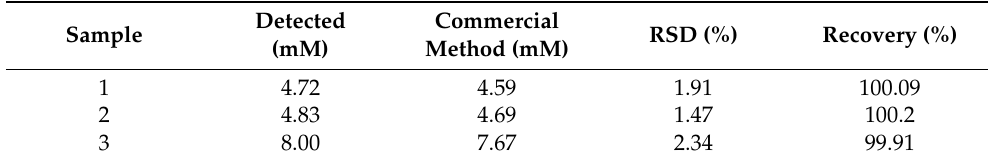
Table 2. Analysis of glucose in human blood serum.